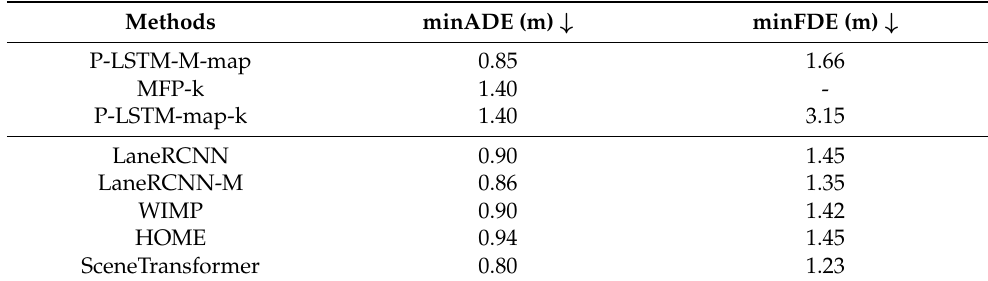
Table 5. Comparison of proposed framework and non-hierarchical multi-modal prediction methods on Argoverse